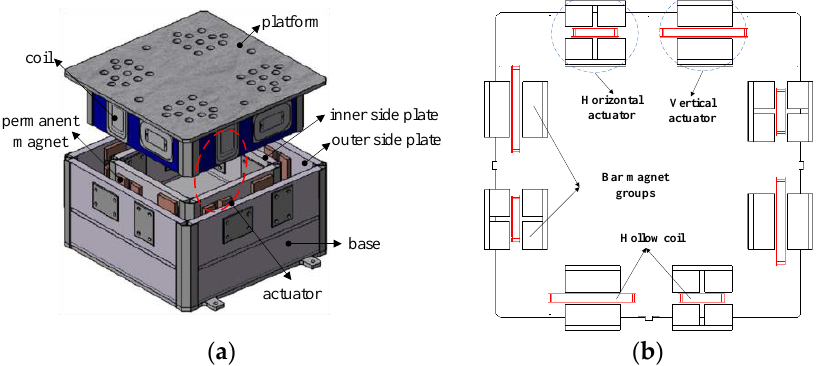
Figure 1. The description of six degrees-of-freedom (DOF) maglev vibration systems: ( a ) The structure of the maglev vibration isolation platform; ( b ) the layout of actuators.